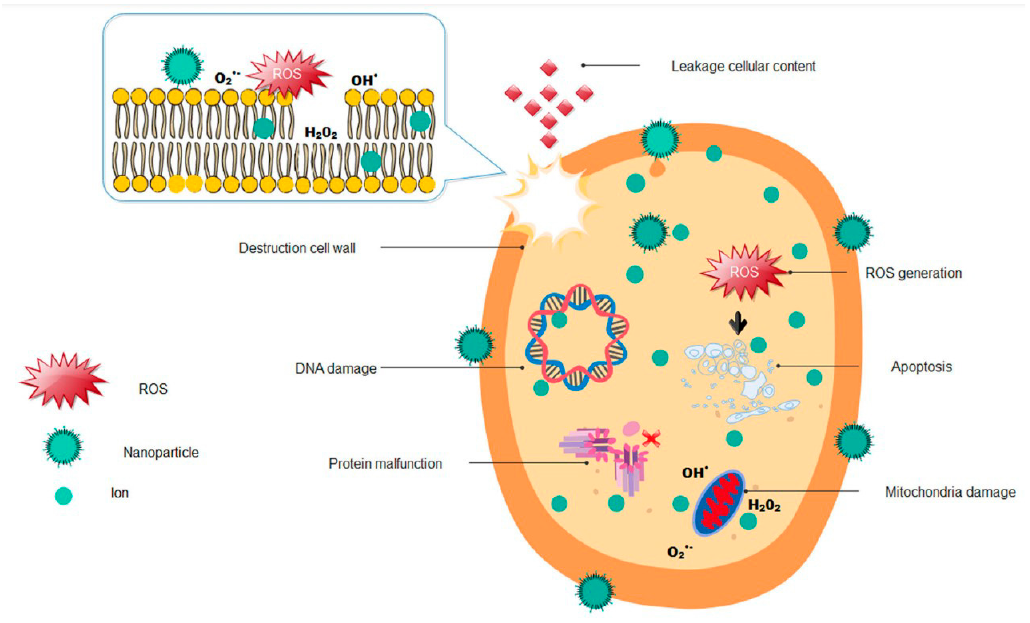
Figure 3. Schematic representation of antimicrobial actions of inorganic-based nanoparticles. Repro- duced with permission from Ref. [35]. Copyright 2020 Wiley-VCH.